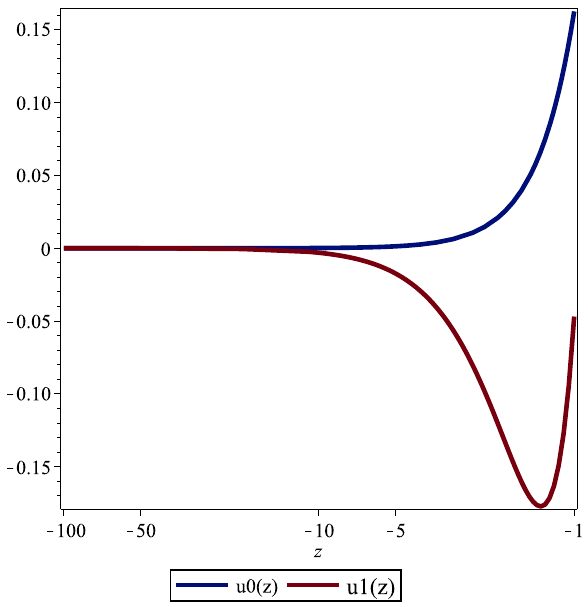
Figure 2. Graphs of functions u 0 ( z ) and u 1 ( z ) .